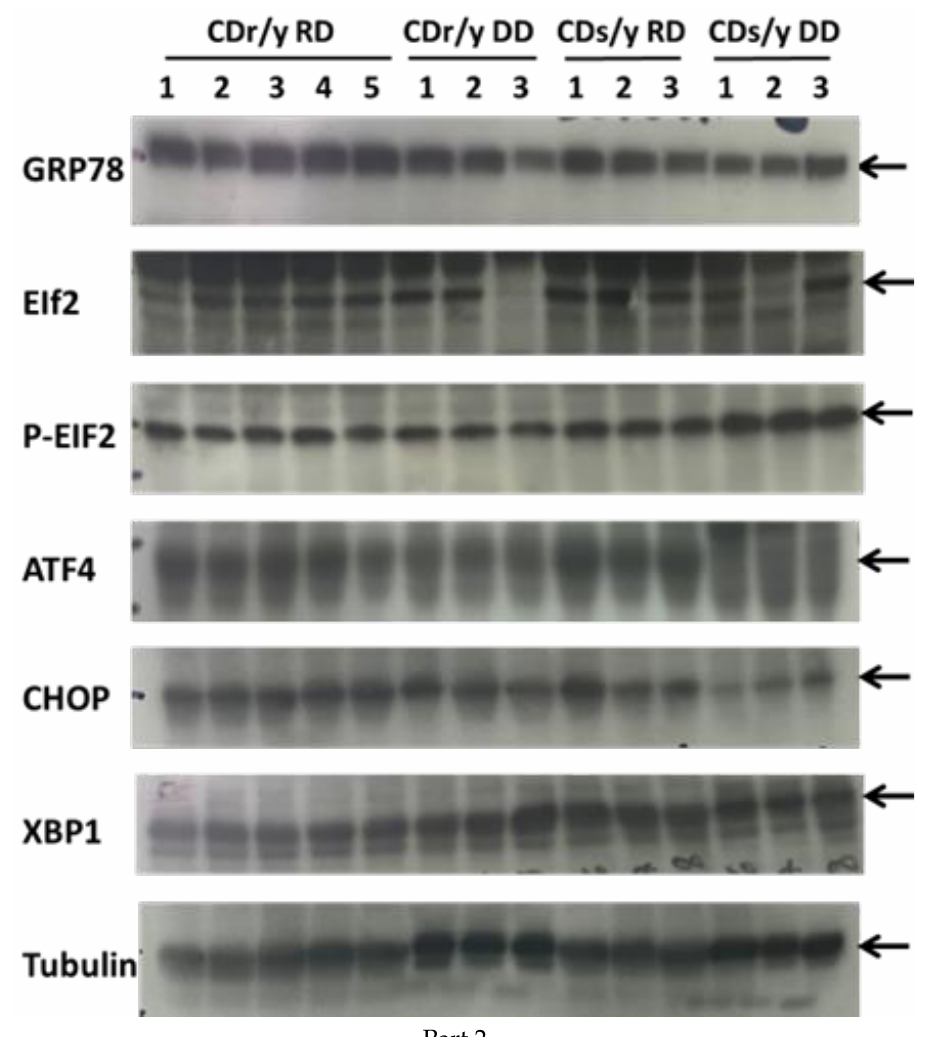
Figure 3. ( Part 1 ) Expression of GRP78/BIP (panels A – C , n = 9–30), eIF2 α (panels D – F , n = 7–23), ATF4 (panels G – I , n = 9–25), CHOP (panels J – L , n = 8–25) and XBP1 (panels M – O , n = 9–25) in the pancreas shown as scattergrams in CDr/y DD (black filled circles), CDs/y RD (open rectangles), and CDs/y DD (black filled rectangles) respectively, and expressed as percent of expression of CDr/y RD, at 4 days and at weekly intervals thereafter, until 4 weeks of the study. All data were corrected for the same 10 CDr/y-RD pooled in five duplicates, which served as reference in each blot to correct for between variations. The horizontal dotted line represents 100% of mean expression in CDr/y RD. * p < 0.05, ** p < 0.01 indicates statistical significance by Student’s t-test of values compared to CDr/y at each given time point. ( Part 2 ) Representative blots of each of the respective proteins quantified by densitometry in part 1 of the Figure, with alpha-tubulin serving as reference